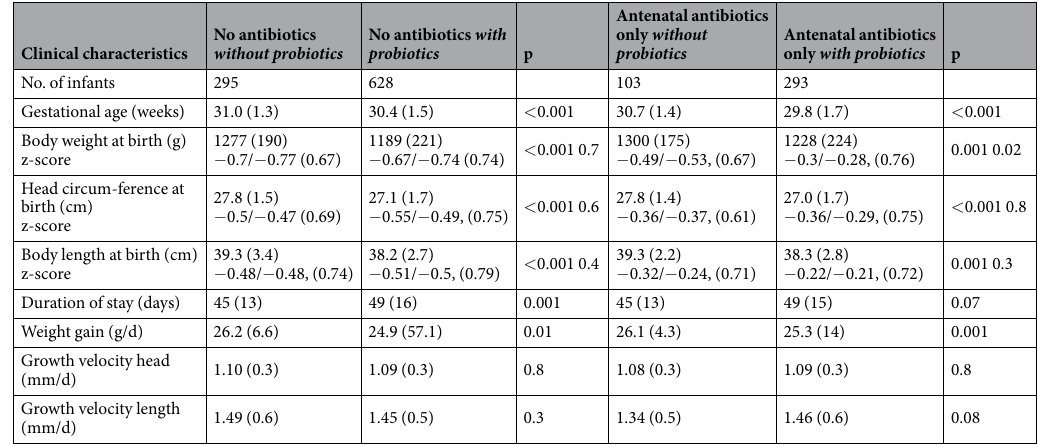
Table 4. Antenatal antibiotics and effect of probiotics. Legend: Continuous variables are shown as mean (SD); z-scores are shown as mean/median (SD). Categorical variables are shown as percent. p-values were derived from Fisher’s exact test or Mann-Whitney-U test if indicated ( * ), SGA, small for gestational age ( < 10th percentile of birth weight adjusted to gestational age). Growth velocity and weight gain were calculated by differences between parameters at birth and respective measures at discharge/number of days (duration of stay).